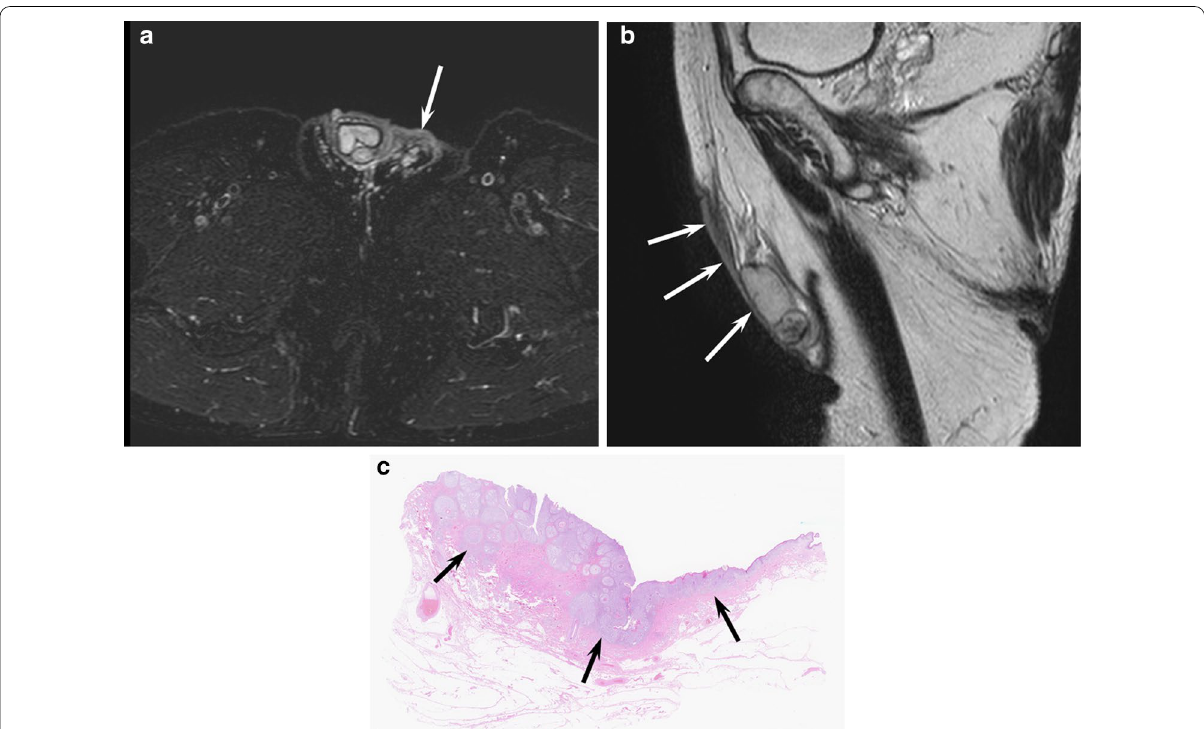
Fig. 7 A 77‑year‑old male with extramammary Paget disease on the perineal region. a Axial T2‑weighted image showing a hyperintense cutaneous mass (arrow). b Sagittal T2‑weighted image showing a cutaneous mass (arrows) with horizontal spread. c Histological specimen (H&E stain; scale bar, 5 mm) showing a horizontally spreading mass within the dermis